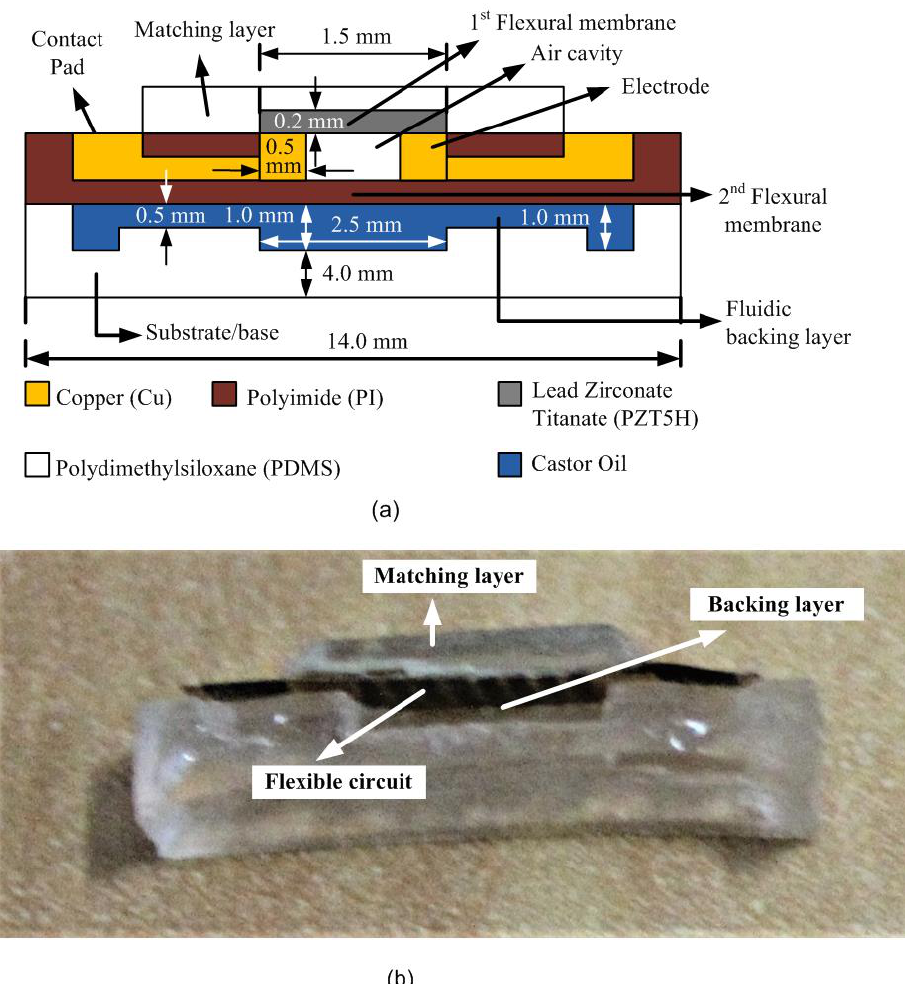
Figure 3. A cross-sectional view of a fluidics-based, double-membrane piezoelectric micromachined ultrasonic transducer: ( a ) schematic diagram; ( b ) digital microscope computer image.